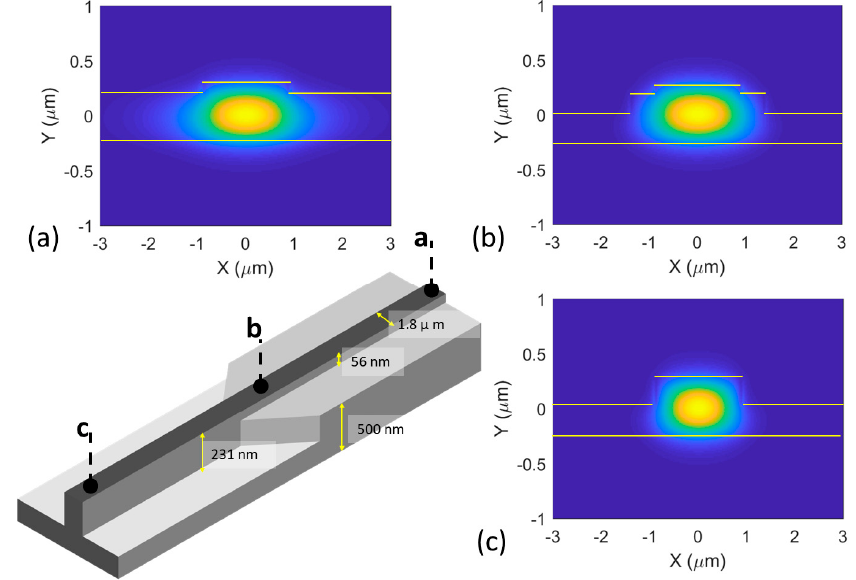
Figure 7. Schematic of the taper converting the optical mode from an ULL waveguide to standard rib (231 nm etch depth) waveguide. Figures ( a – c ) show the waveguide mode profiles at locations labeled a—ULL silicon waveguide, b—central part of the taper, and c—standard silicon waveguide along the taper structure.